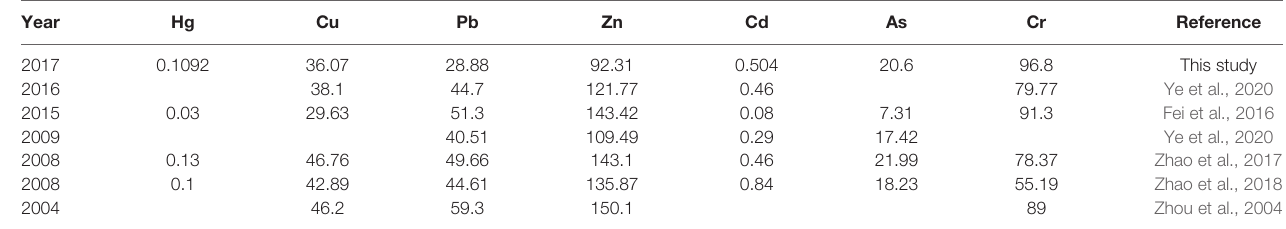
TABLE 3 | Average of heavy metal concentrations in study